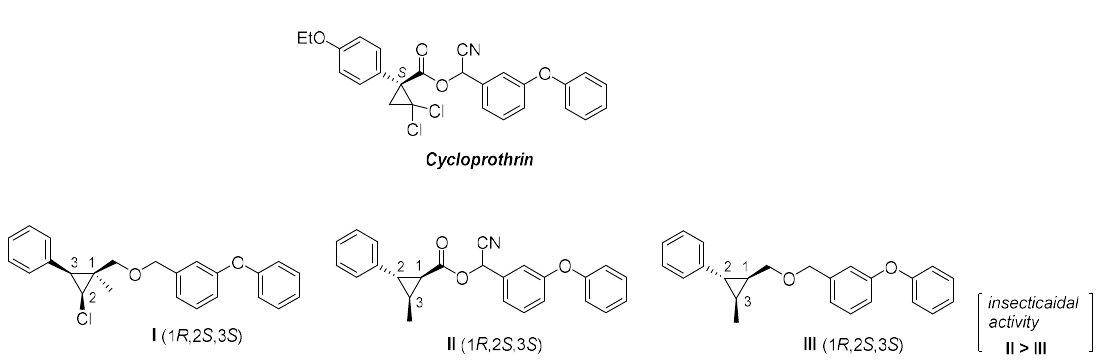
Figure 1. Two representative non-cyclopropane-type pyrethroids.